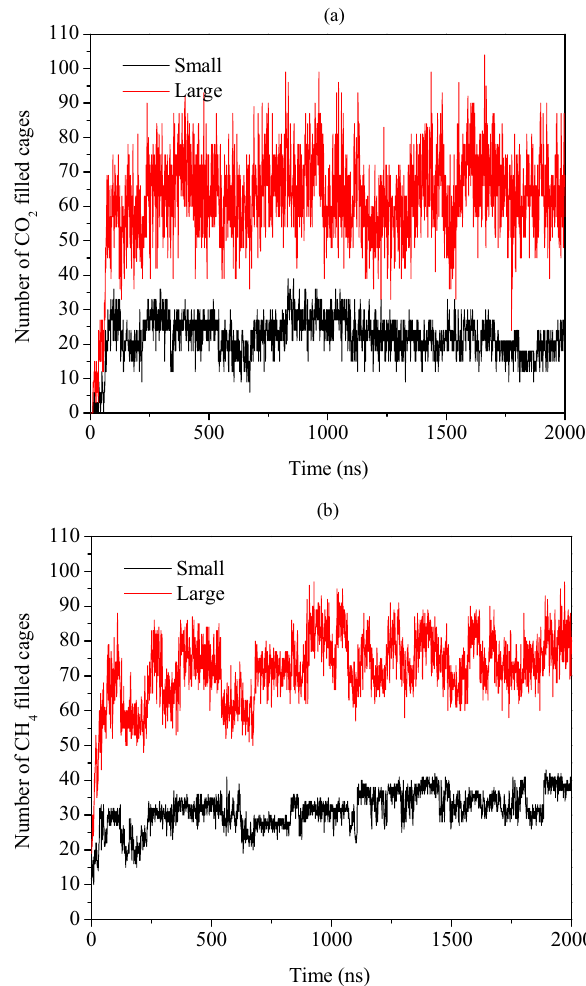
Figure 5. Plot of number of filled cages of ( a ) CO 2 and ( b ) CH 4 hydrates during the CH 4 –CO 2 replacement dynamics in presence of free water molecules with operating pressure and temperature of 50 MPa and 260 K,